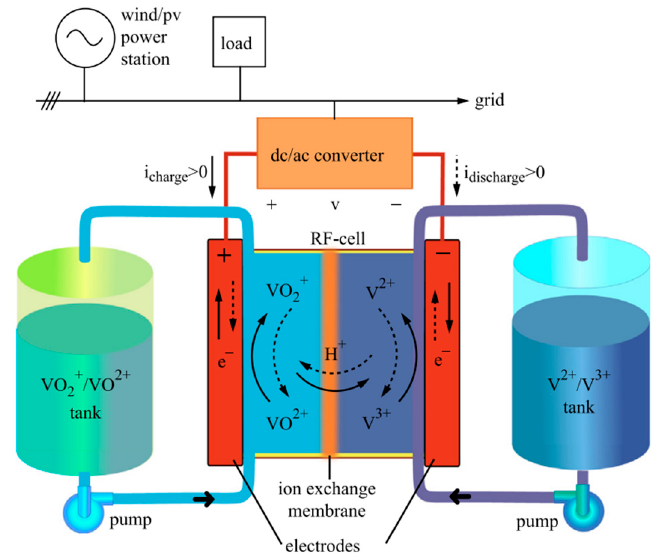
Figure 18. Fe 3+ /Fe 2+ and Cr 2+ /Cr 3+ redox flow battery.